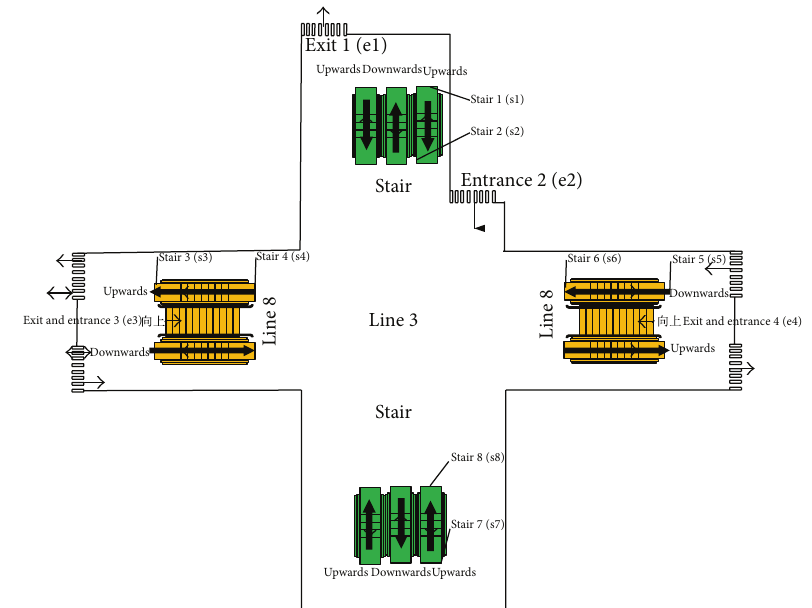
Figure 2: Layout of first floor of Kecun